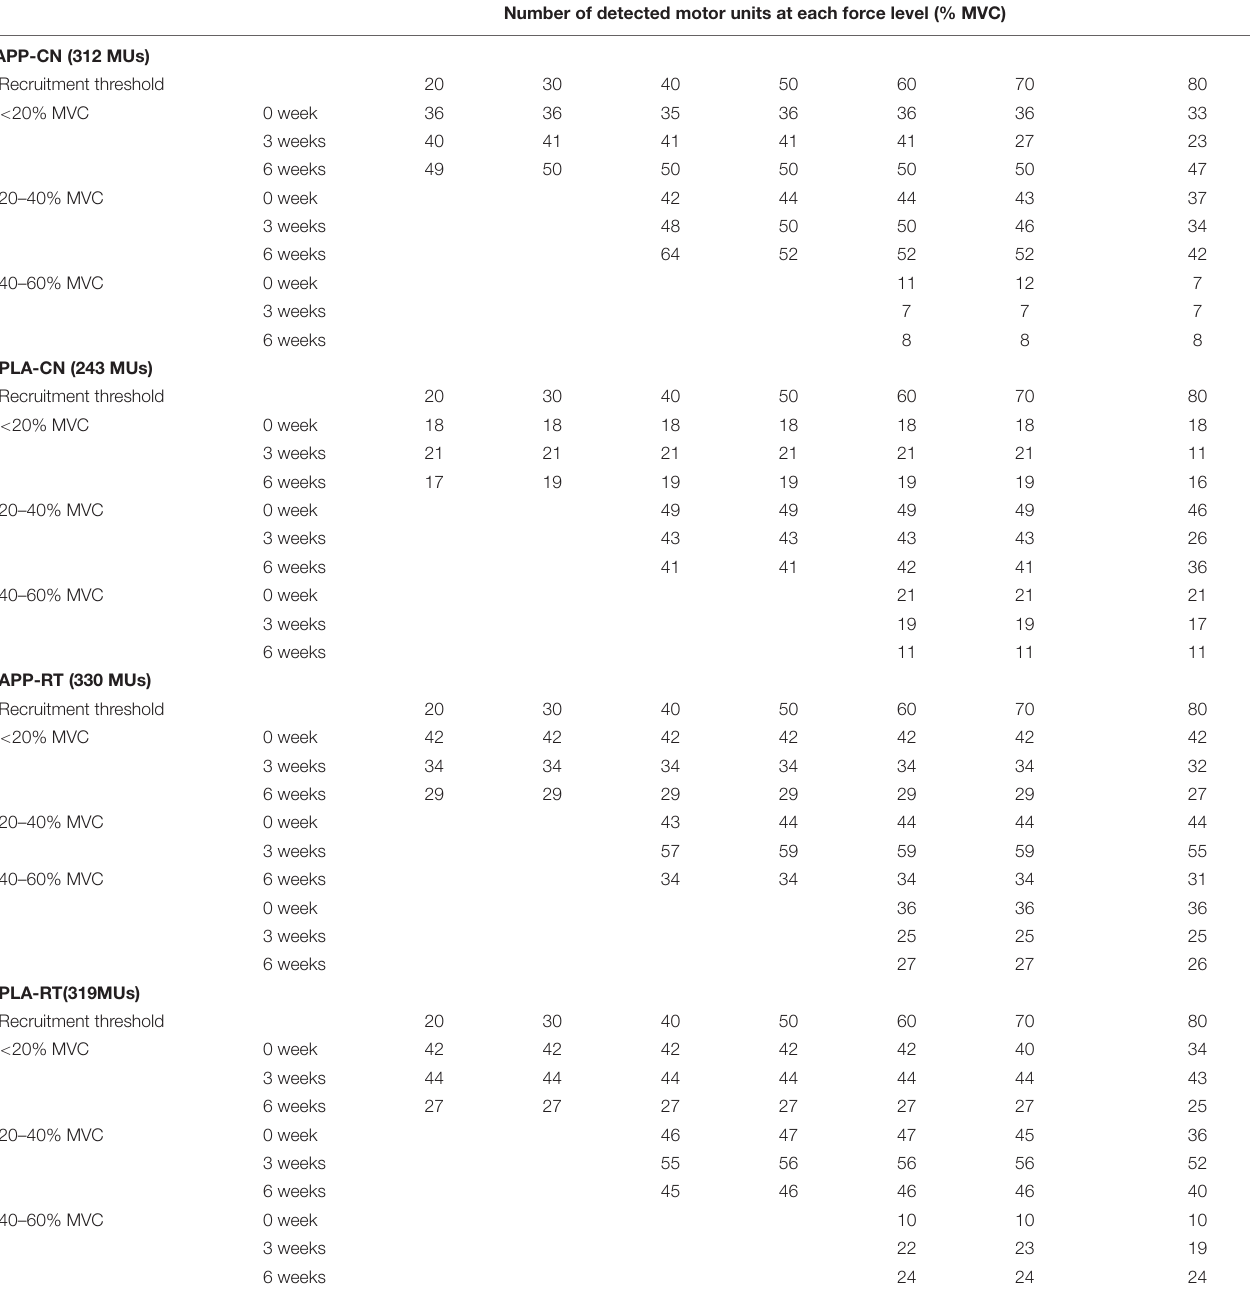
TABLE 4 | Number of motor units detected and considered for analysis for each group. Number of detected motor units at each force level (%